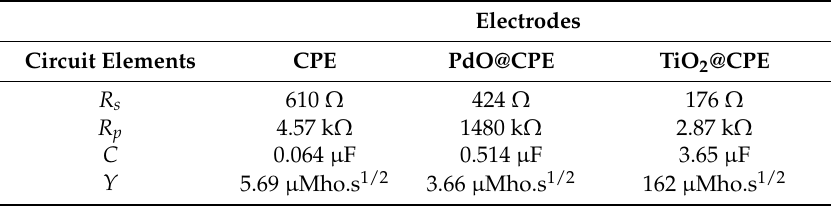
Table 2. Randles equivalent circuit elements for each electrode.